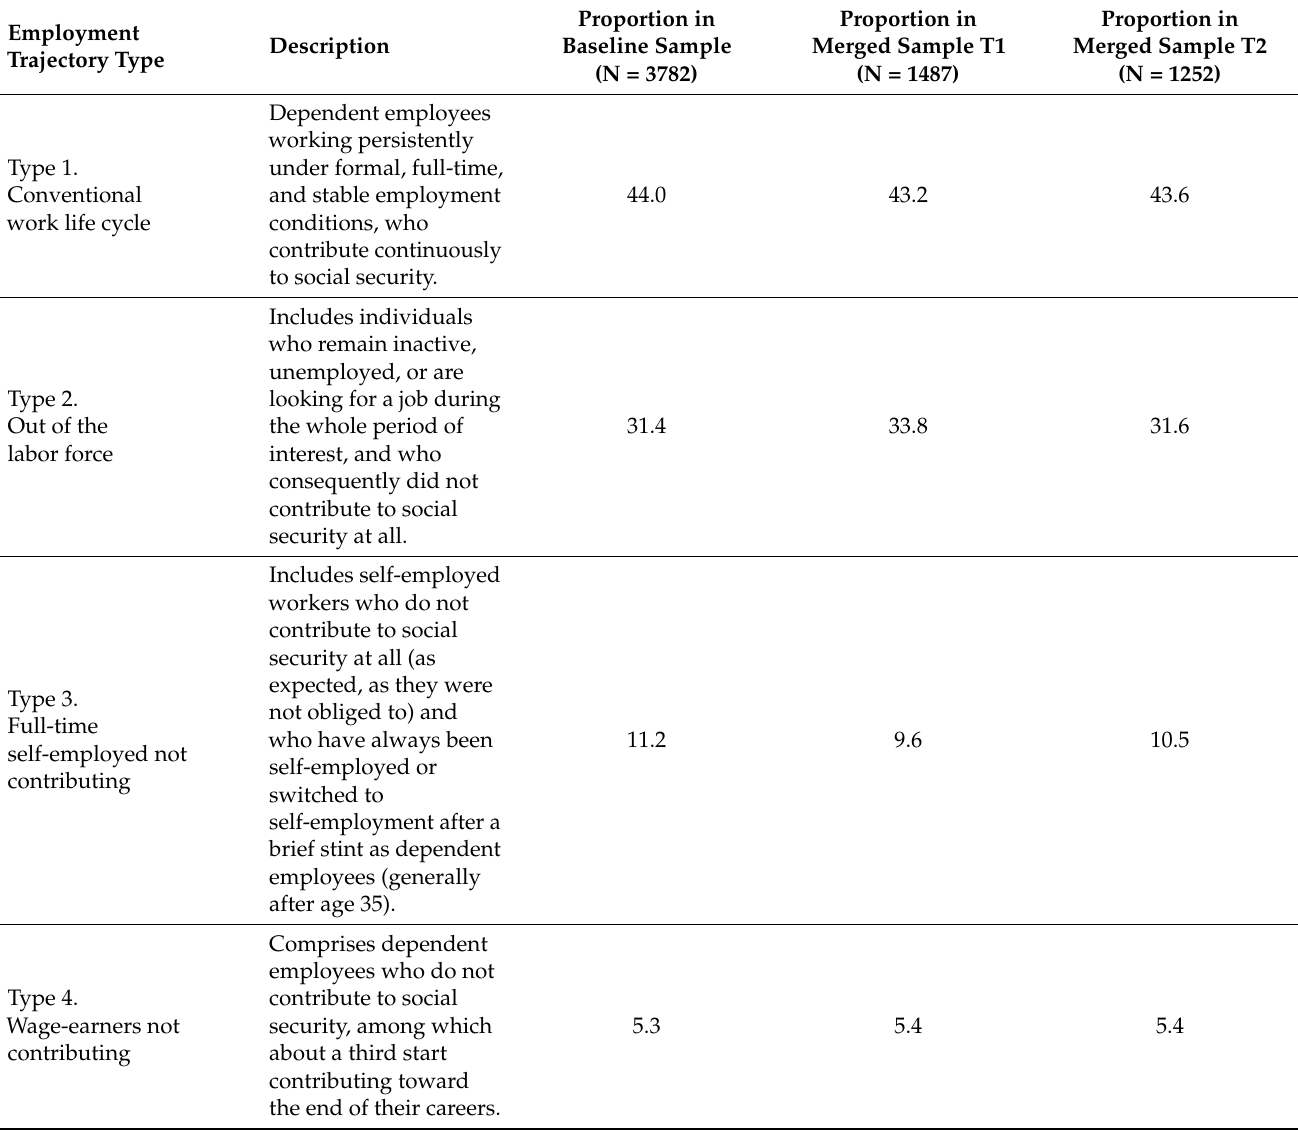
Table 1. Types of adulthood employment trajectories and proportion (%) across the study